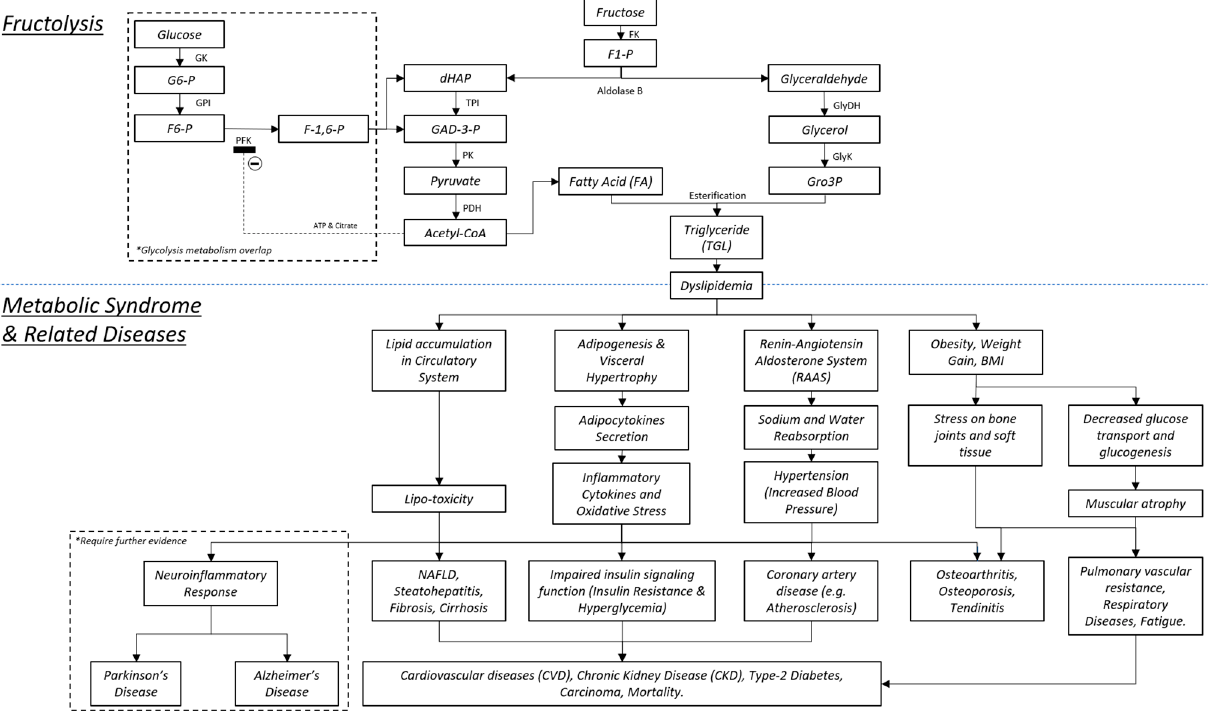
Figure 1. Fructose enzymatic process and physiological impacts to achieve MetS and related diseases. Abbreviations: GK, glucosekinase; G6-P, glucose-6-phosphate; GPI, phosphoglucose isomerase; PFK, phosphofructokinase-1; F-1,6-P, fructose-1,6-phosphate; dHAP, dihydroxyacetone phosphate; TPi, triophosphate isomerase; GAD-3-P, glyceraldehyde-3-phosphate; PK, phosphofructokinase; PDH, pyruvate dehydrogenase; FK, fructokinase; F1-P, fructose-1-phosphate; GlyDH, glycerol dehydrogenase, GlyK, glycerate kinase.